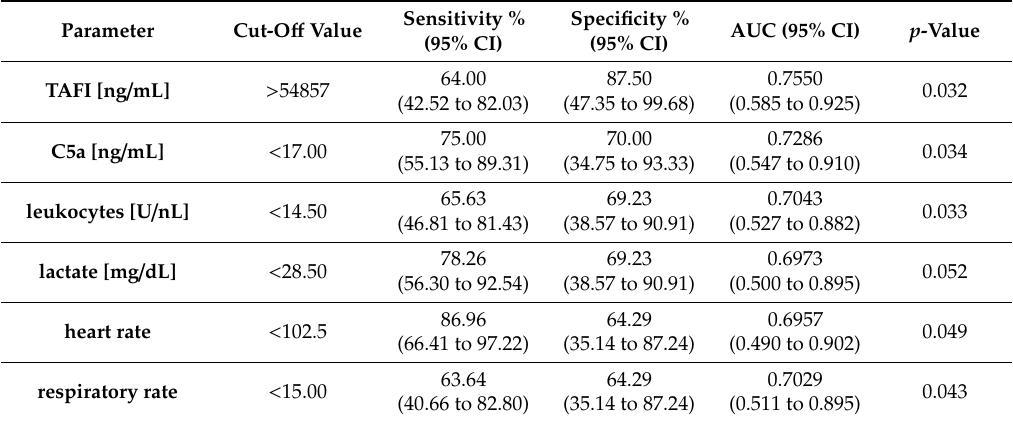
Table 5. Receiver-operator curve (ROC) analyses on TAFI, C5a, leukocyte count, lactate level, heart rate, and respiratory rate at admission to the emergency department to predict the development of sepsis after polytrauma. Sensitivity and specificity are given as percentage values. Abbreviations: AUC, area under the curve and CI, confidence interval.